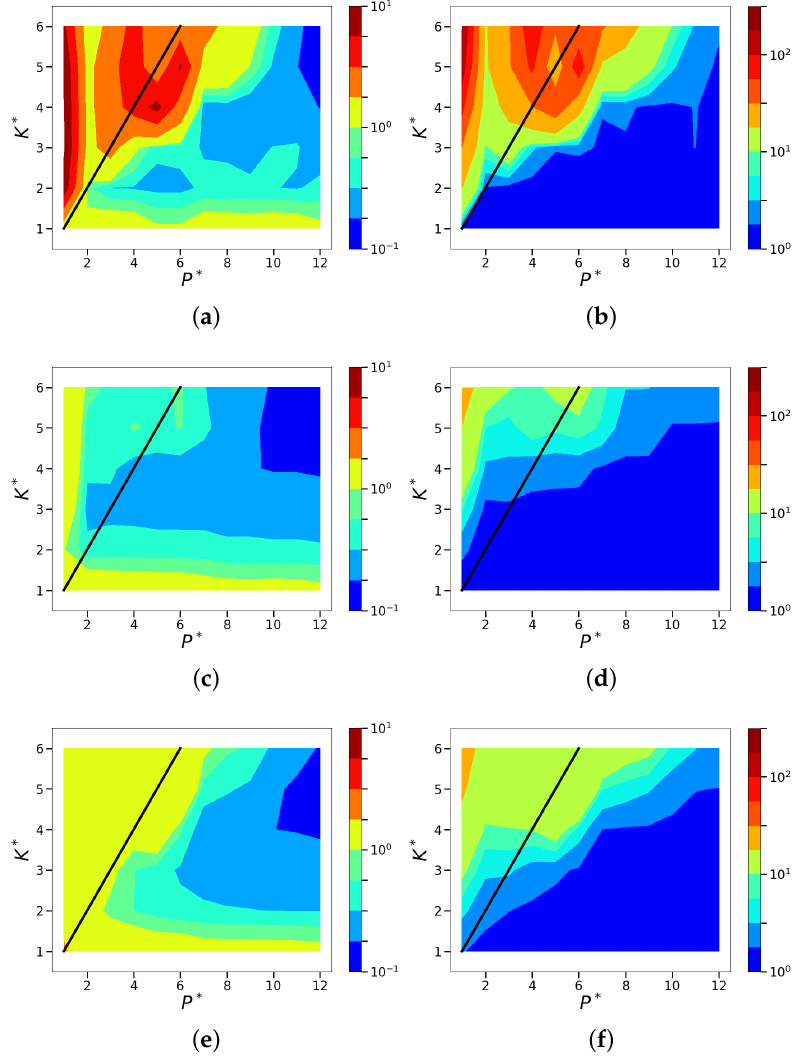
Figure A6. Isocontours of the normalized mean squared POD-based sparse reconstruction errors ( l 2 norm) for Re = 800 case, corresponding to the sensor placement with maximum and minimum errors from the chosen ensemble. The average error across the entire ensemble of ten random sensor placements is also shown. Left: normalized absolute error metric, (cid:101) 1 . Right: normalized relative error metric, (cid:101) 2 . ( a ) (cid:101) 1 (maximum); ( b ) (cid:101) 2 (maximum); ( c ) (cid:101) 1 (minimum); ( d ) (cid:101) 2 (minimum); ( e ) (cid:101) 1 (average); and ( f ) (cid:101) 2